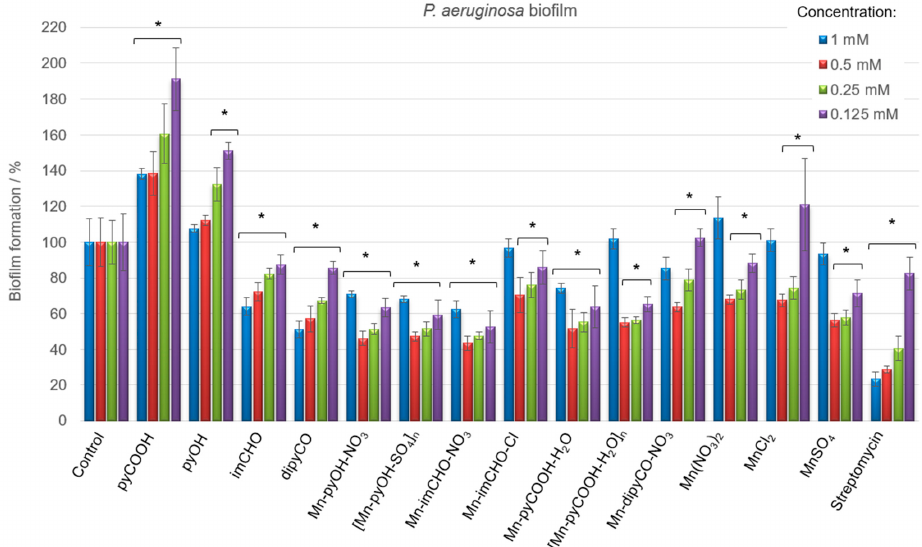
Figure 8. P. aeruginosa PAO1 biofilm formation in the presence of the Mn(II) complexes, free ligands, and Mn(II) salts (concentrations of compounds—1–0.125 mM). The absorbance of the control was considered to represent 100% of biofilm formation (results were considered significant when compared to control; * p < 0.05. Data are presented as mean ± SD, n = 4).